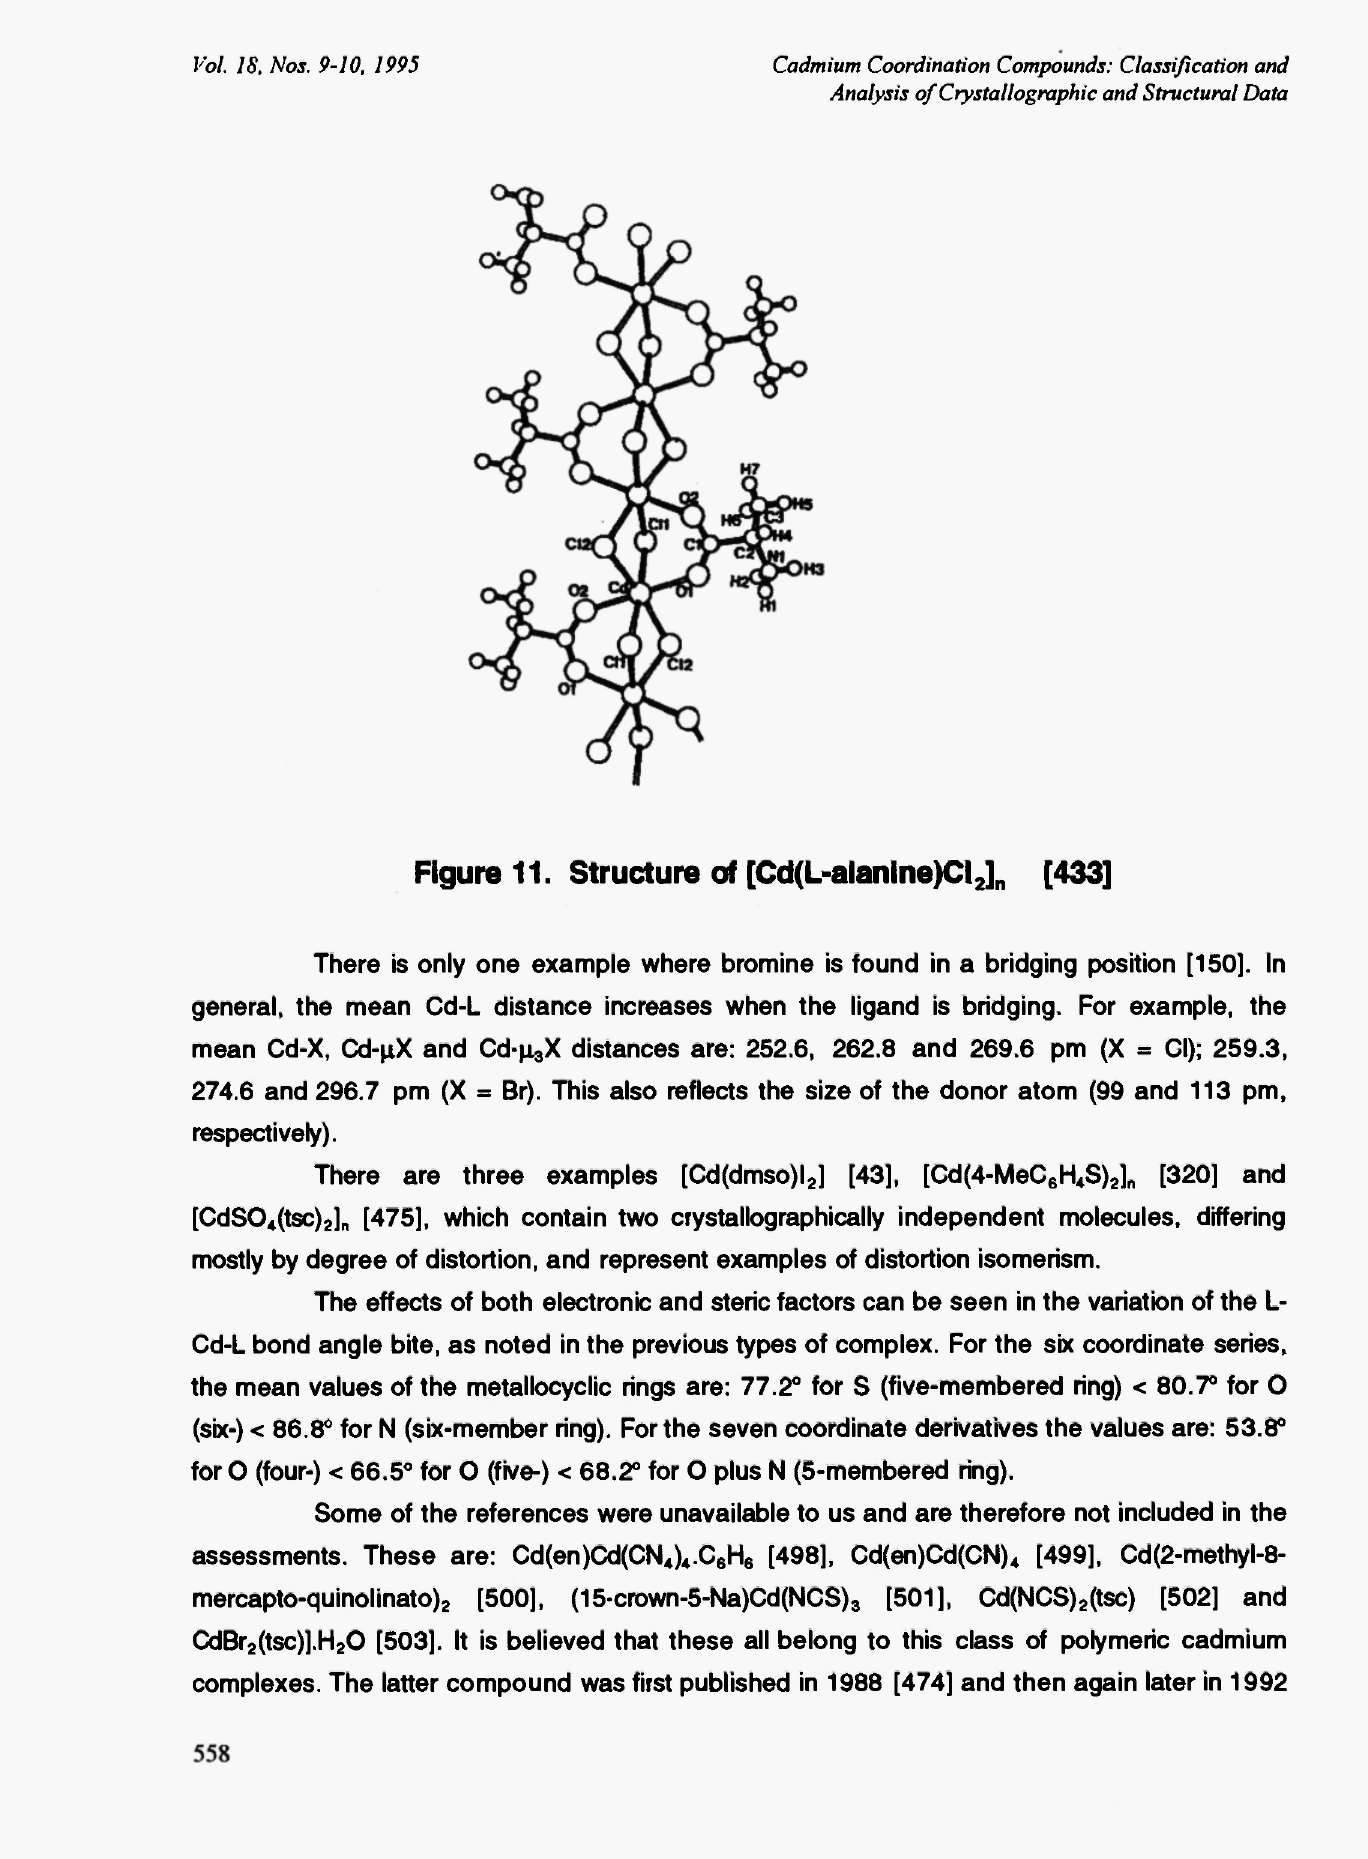
Figure 11. Structure of [Cd(L-alanine)CI